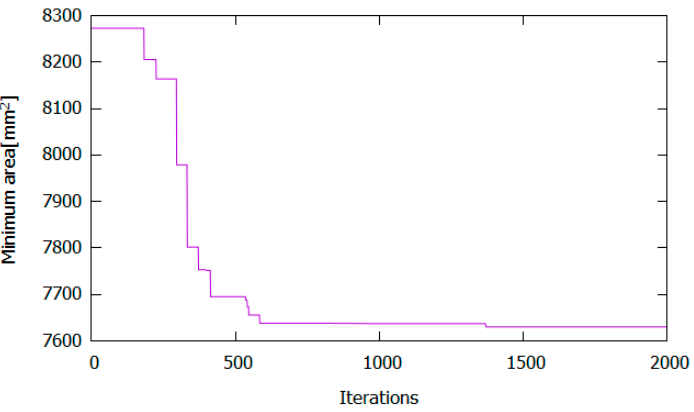
Figure 7. Variation in the minimum cross-sectional area with noncompact web in the first 2000 harmony search iterations .